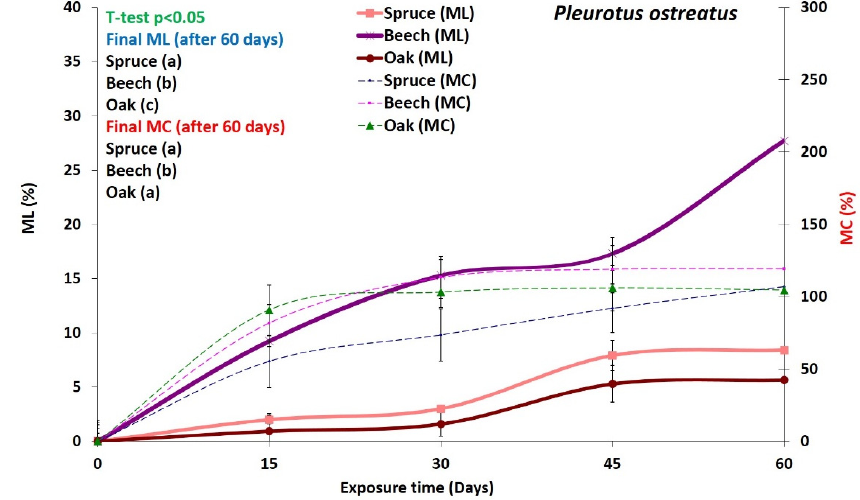
Figure 1. Mass loss (ML) and moisture content (MC) of wood decayed by the white-rot fungus Pleurotus ostreatus for 60 days incubation. Average of twelve replicates ± SD. t -test p < 0.05.